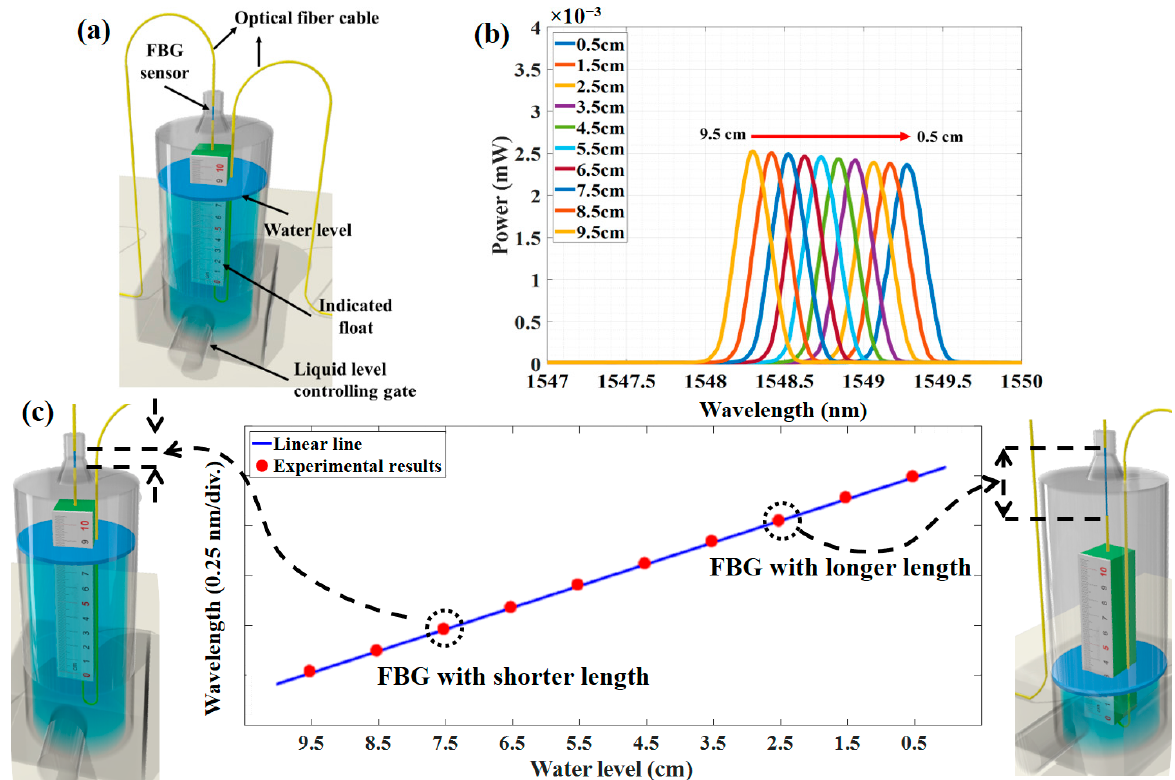
Figure 2. ( a ) The scheme of water level sensor structure that an FBG sensor connected to the indicated float. The water level can be controlled by the controlling gate. ( b ) The power versus wavelength of the reflected spectra of 10 different water level steps, and ( c ) the linear shift in wavelength when the water level change from 9.5 cm to 0.5 cm with the steps of 0.5 cm.